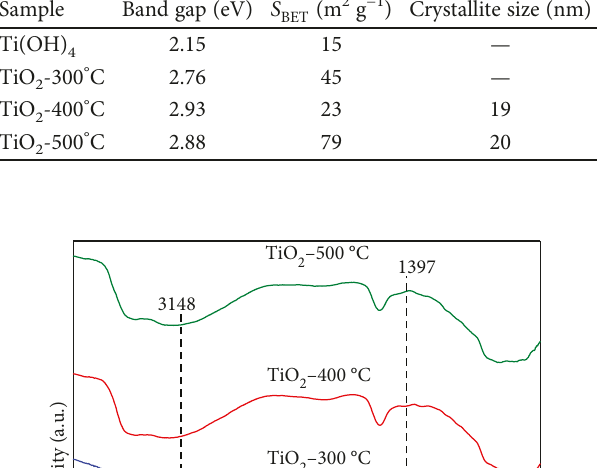
, TiO -300 ° C, TiO 4 2